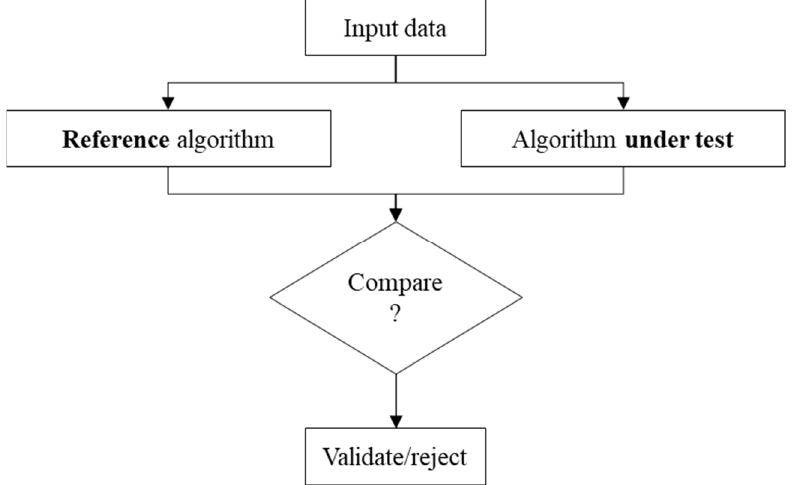
Figure 2. Illustration of the type F1 algorithm measurement standard.